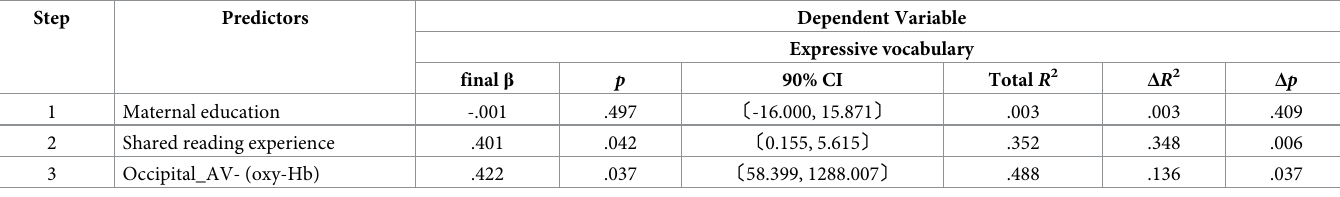
Table 2. Hierarchical regression